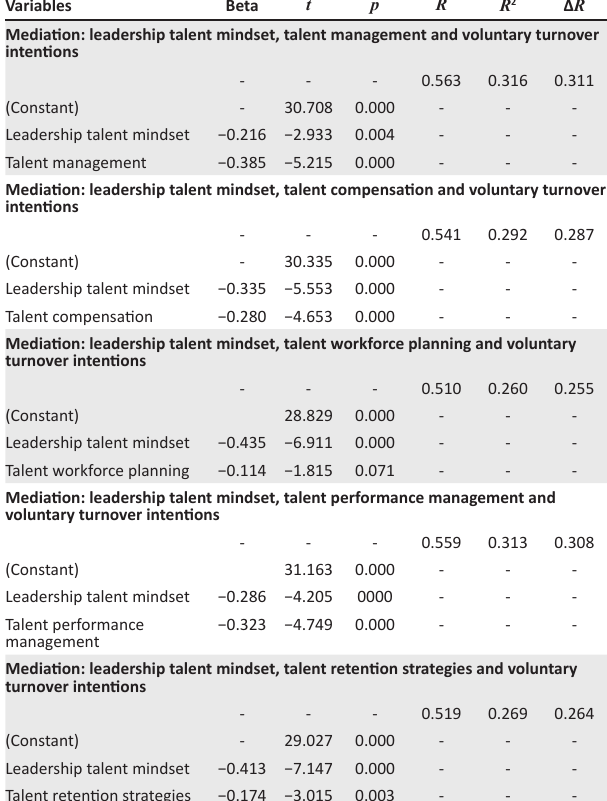
TABLE 4: Results of mediation analyses. Variables